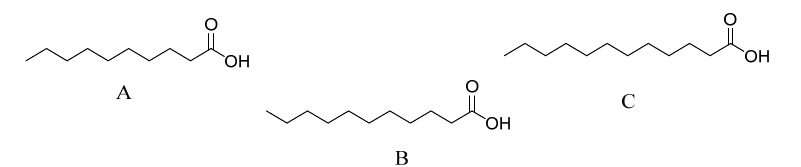
Figure 2. The most active medium-chain fatty acids from Eugenia winzerlingii leaves, ( A ) decanoic acid, ( B ) undecanoic acid, and ( C ) dodecanoic acid.